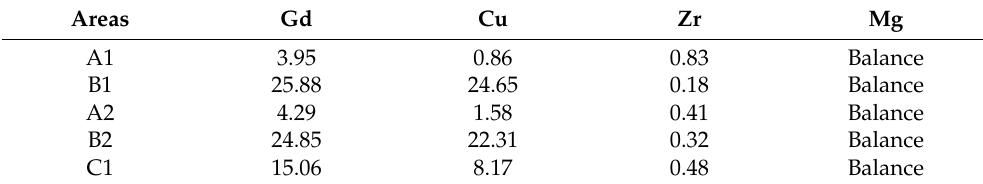
Figure 2. SEM micrographs of the alloy perpendicular ( a , c ) and parallel ( b , d ) to the extrusion direction for the ( a , b ) as-extruded alloy and ( c , d ) as-aged alloy. Table 1. Chemical compositions (wt.%) of the marked areas in Figure 2.